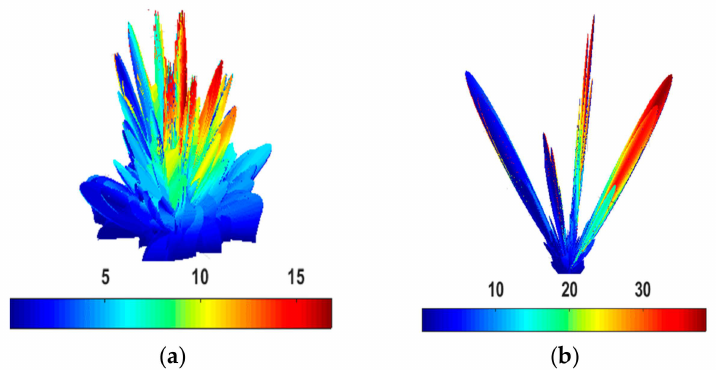
Figure 8. ( a ) Coding diffusion metasurface three-dimensional (3-D) plot of scattering field; ( b ) Chessboard metasurface 3-D plot of scattering field.